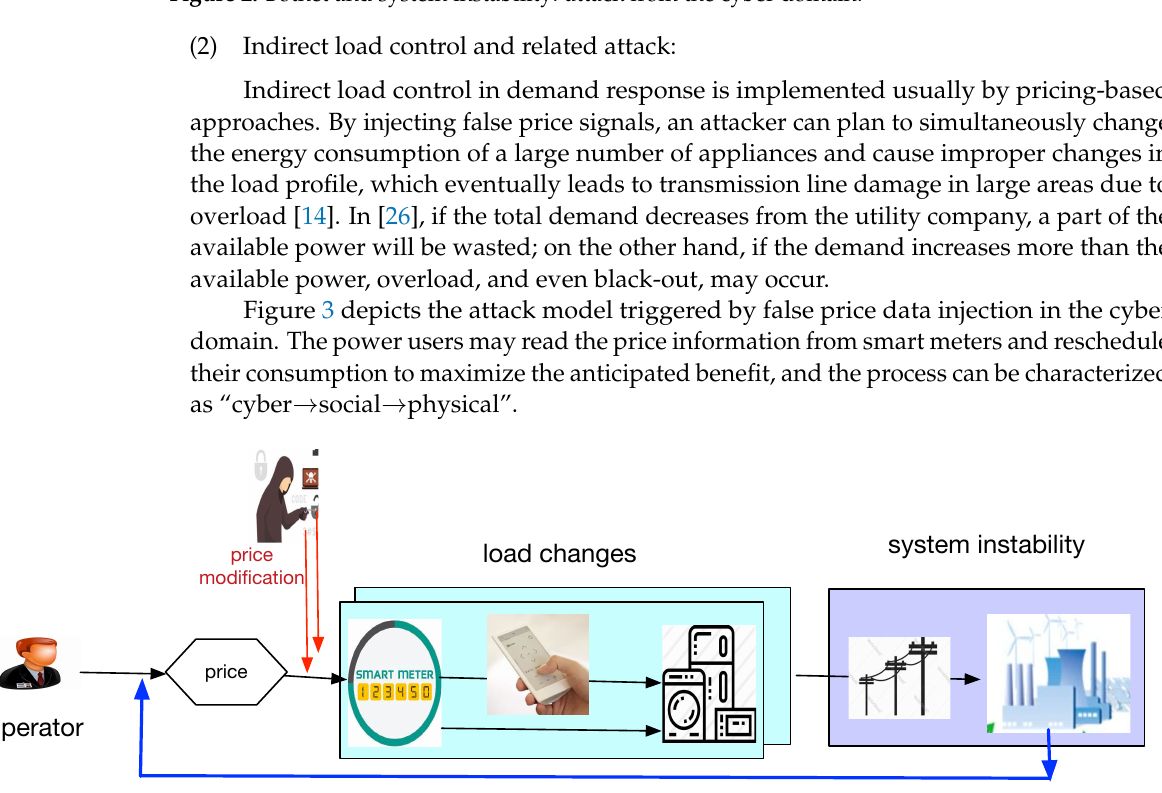
Figure 2. Botnet and system instability: attack from the cyber domain.